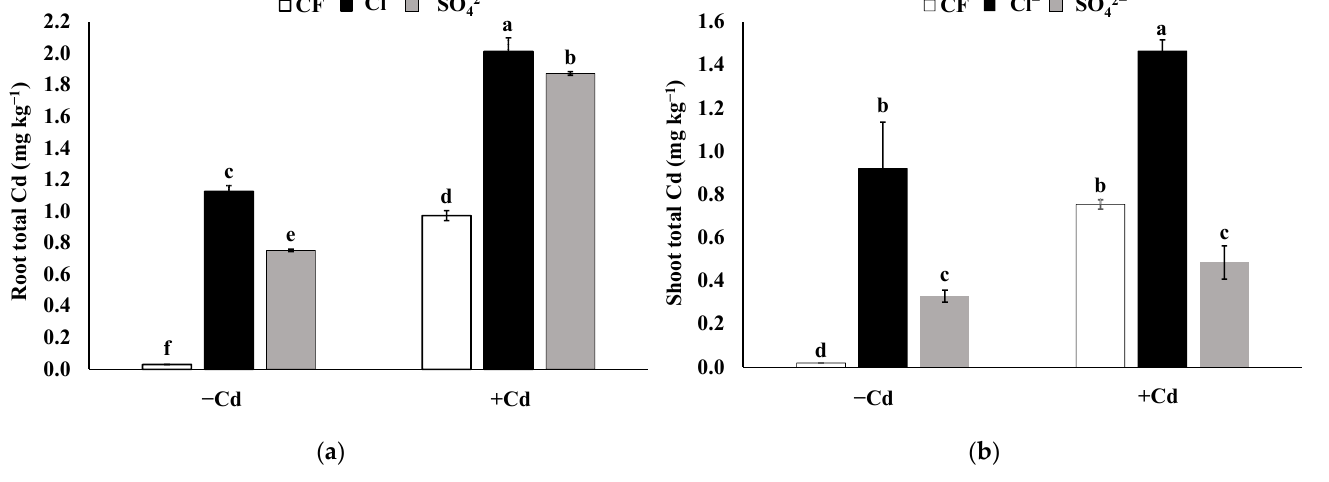
Figure 3. Effect of Cl − - and SO 42 − -based fertilizers on rice root and shoot total Cd in the Cd1.2 (1.2 mg Cd kg − 1 ) and Cd0 (0 mg Cd kg − 1 ) treatments. ( a ) In the roots and ( b ) in the shoots. Vertical bars represent the standard deviation ( n = 3). Different lower-case letters indicate significant differences at p < 0.05 according to Duncan’s test.